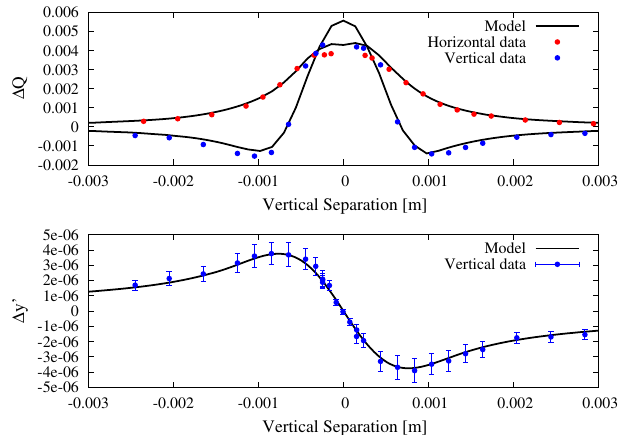
FIG. 12. Change of gold beam tunes Q closed orbit angle at the electron lens (bottom) in response to a vertical displacement.